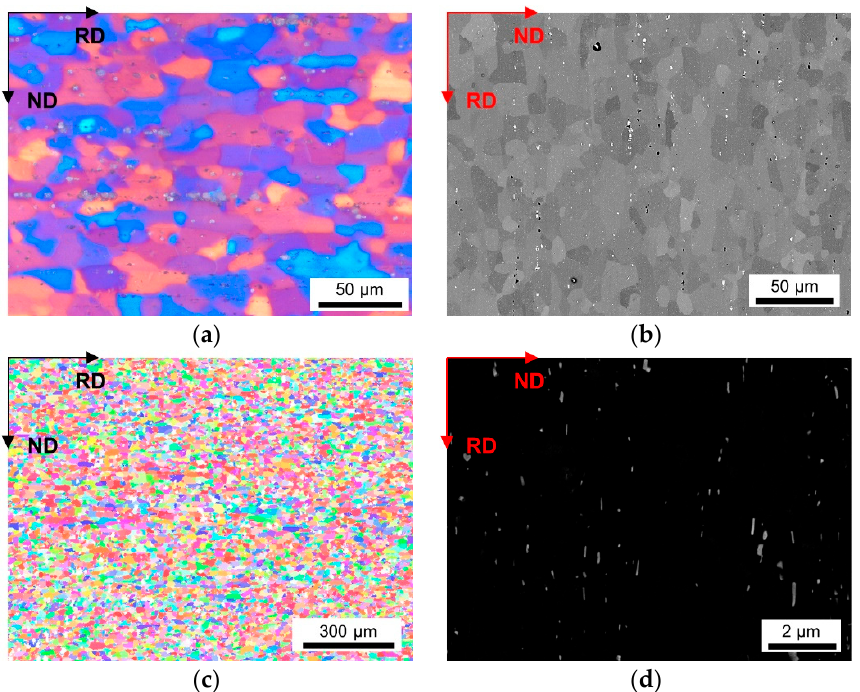
Figure A10. Microstructure of the soft annealed LFe-HMn cast under NR-C condition, homogenized at 500 °C and cold rolled to a CRD of 35%. ( a ) LOM. ( b ) BSE image. ( c ) EBSD IPF map in RD–ND plane. ( d ) BSE micrograph showing dispersoids.